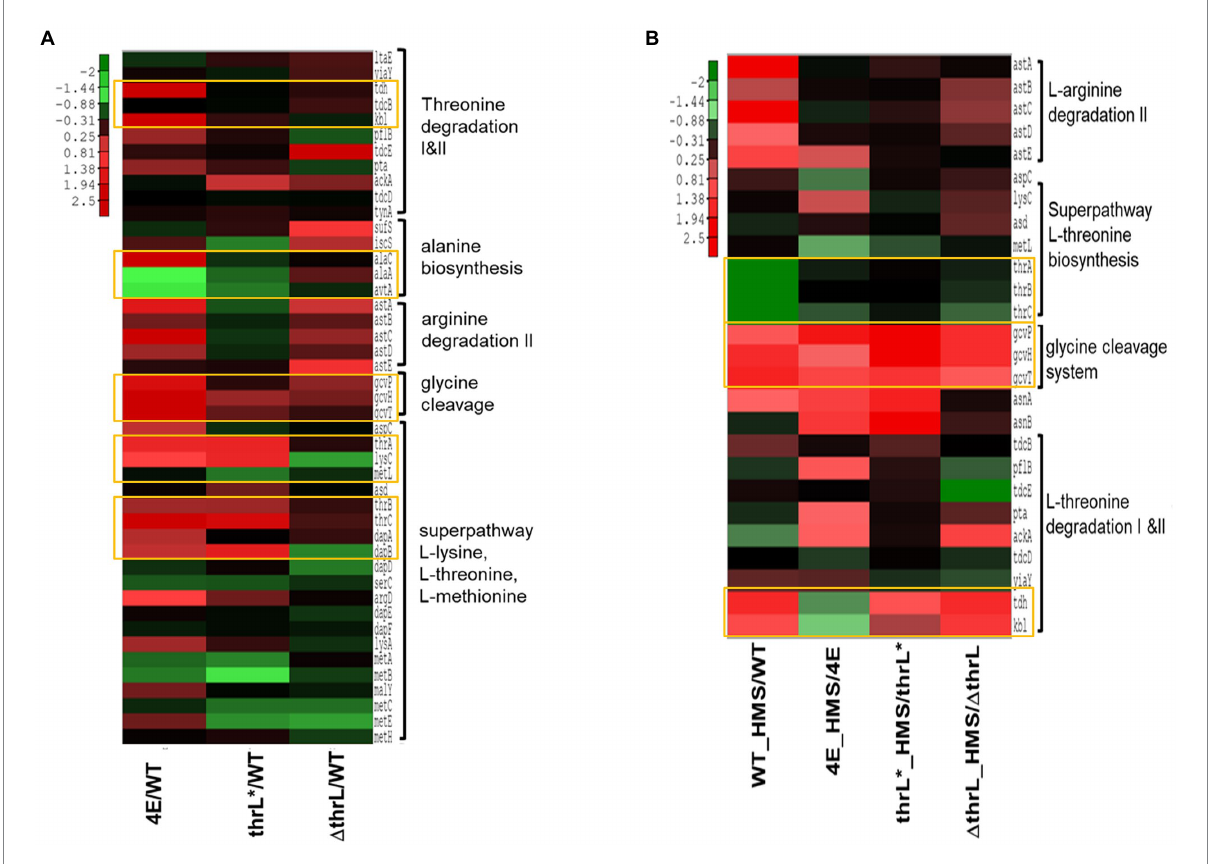
FIGURE 6 Heat map representation of the expression of genes implicated in threonine, glycine, L-alanine and L-arginine superpathway. In (A) is shown expression of these genes in homoserine-adapted (4E), MG1655thrL* (thrL*) and MG1655 Δ thrl ( Δ thrL) strains versus that in WT when cultivated in M9 medium. In (B) is shown the expression of these genes in strains 4E, thrL* , Δ thrL , and WT in the presence versus the absence of 10 mM L-homoserine. Up- and down-regulated genes (at least 2-fold variation and a p value <0.05) were analysed by a clustering method described in Material and Methods. The expression fold of repression (green) or activation (red) of genes is shown by color-coded bar.